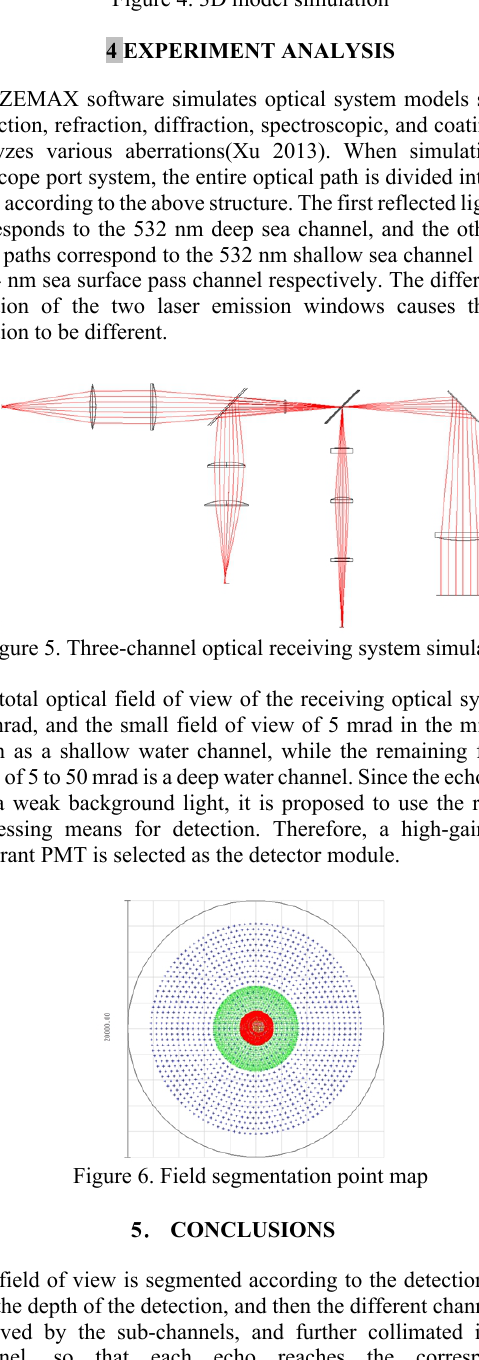
Figure 4. 3D model simulation